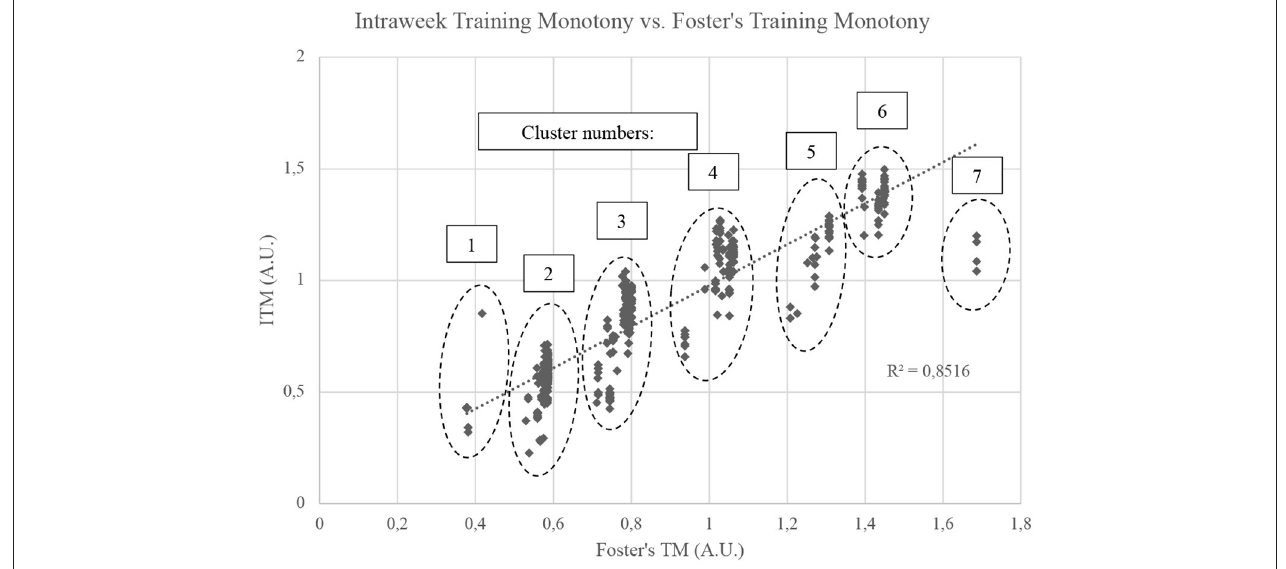
FIGURE 7 | Relationships between Intraweek Training Monotony and Foster’s Training Monotony. A.U., Arbitrary units.